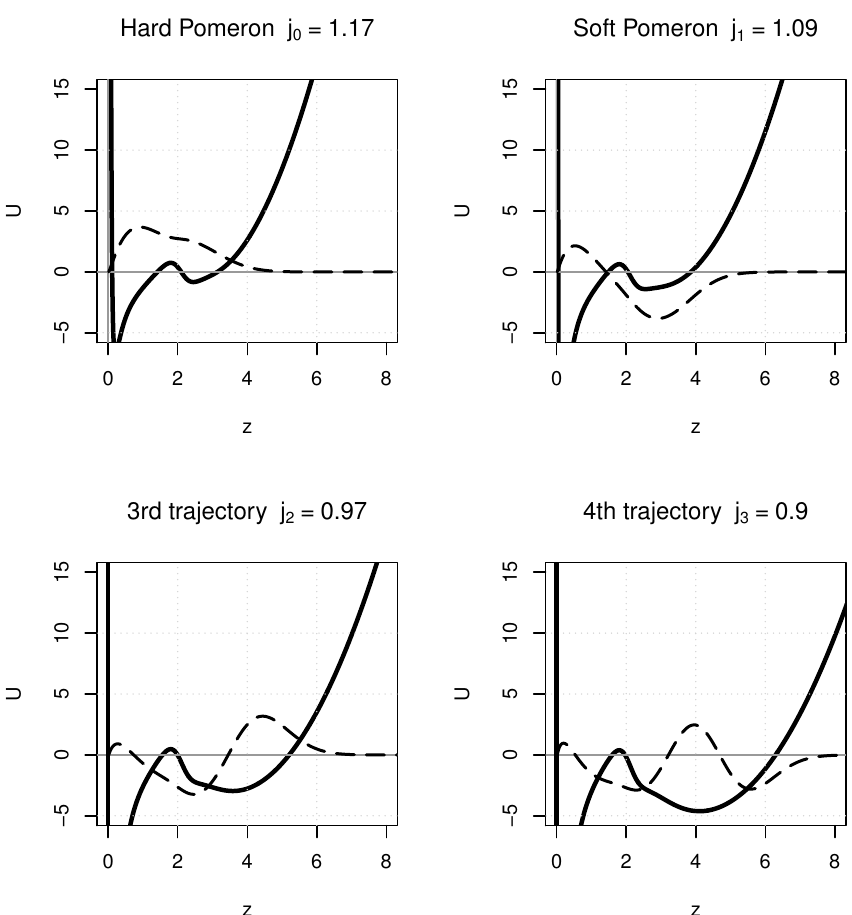
Figure 8 . Wavefunctions and corresponding potential for optimal phenomenological values for the hard and soft pomerons, and also for the other daughter trajectories considered in the (cid:12)t. The normalized wavefunctions have been scaled by 5 in this